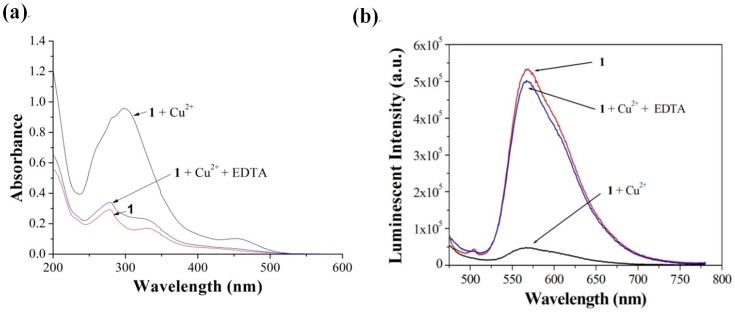
Absorption spectra (a) and luminescence emission spectra (b) of complex 1 (1 µM).Complex 1/Cu2+([1] = 1 µM, [Cu2+] = 10 µM), and complex 1/Cu2+/EDTA in CH3CN solution ([1] = 1 µM, [Cu2+] = 10 µM, [EDTA] = 20 µM).